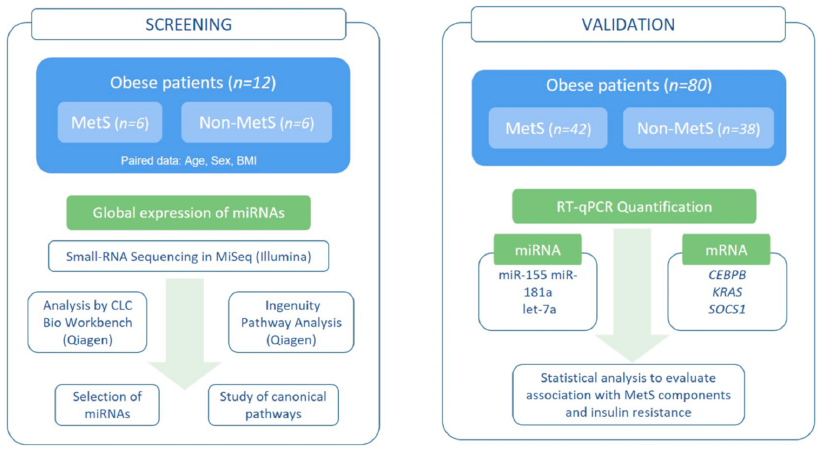
Figure 1. Workflow of the study protocol. MetS: Metabolic Syndrome; BMI: Body mass